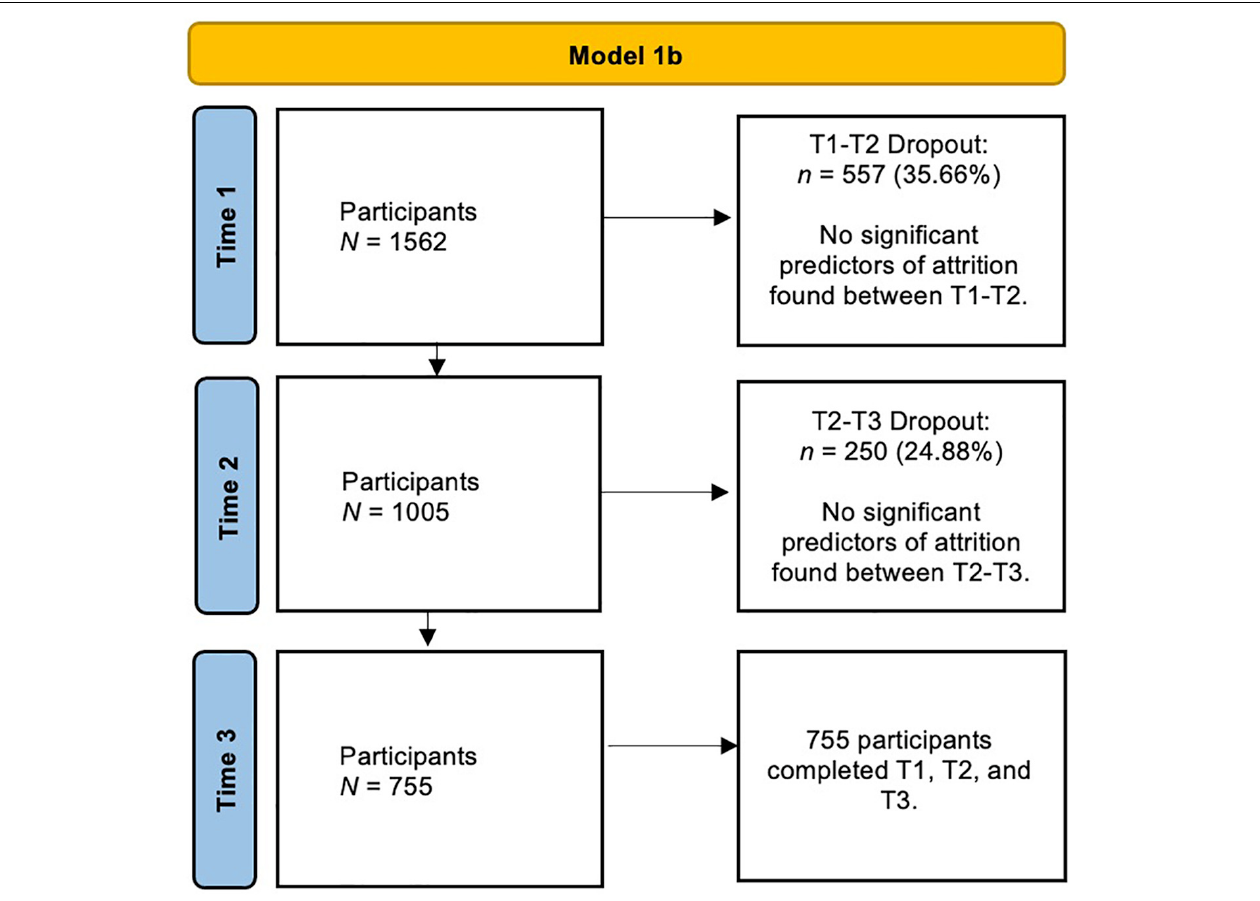
FIGURE 1 | Flowchart for participants in Model 1b. Multivariate latent growth curve model (MLGC) accounts for missing data, and those who had a subsequent timepoint are considered